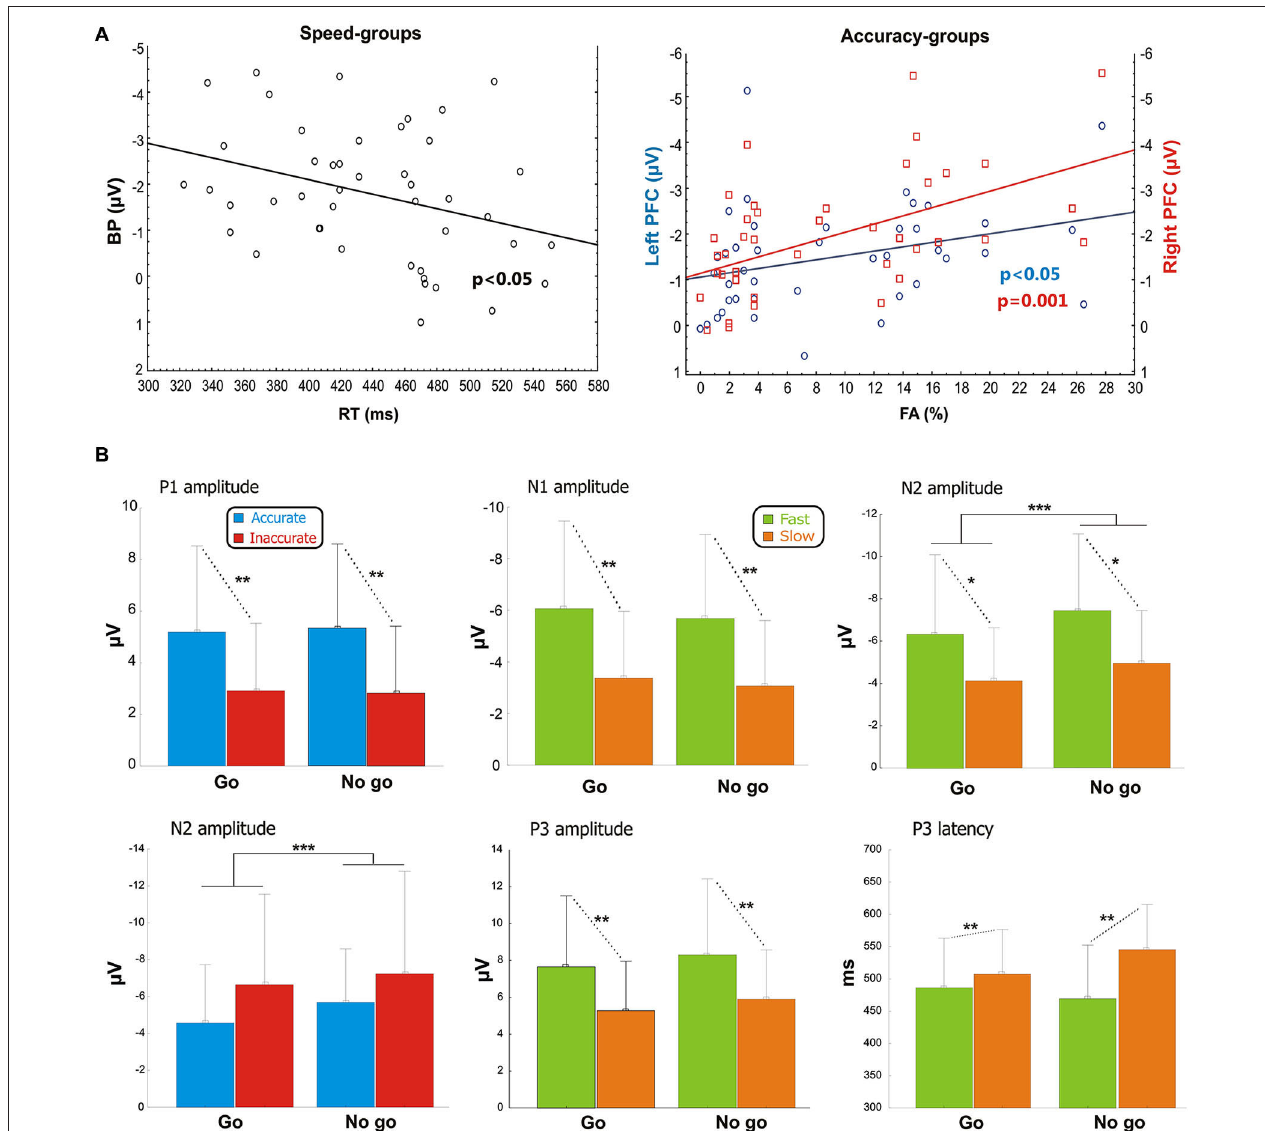
deviations of the main ERPs components. From the upper left: P1 amplitude in Accuracy-groups; N1 amplitude in Speed-groups; N2 amplitude in Speed- groups; N2 amplitude in Accuracy-groups; P3 amplitude in Speed-groups; P3 latency in Speed-groups. * p < 0.05; ** p < 0.01; *** p <